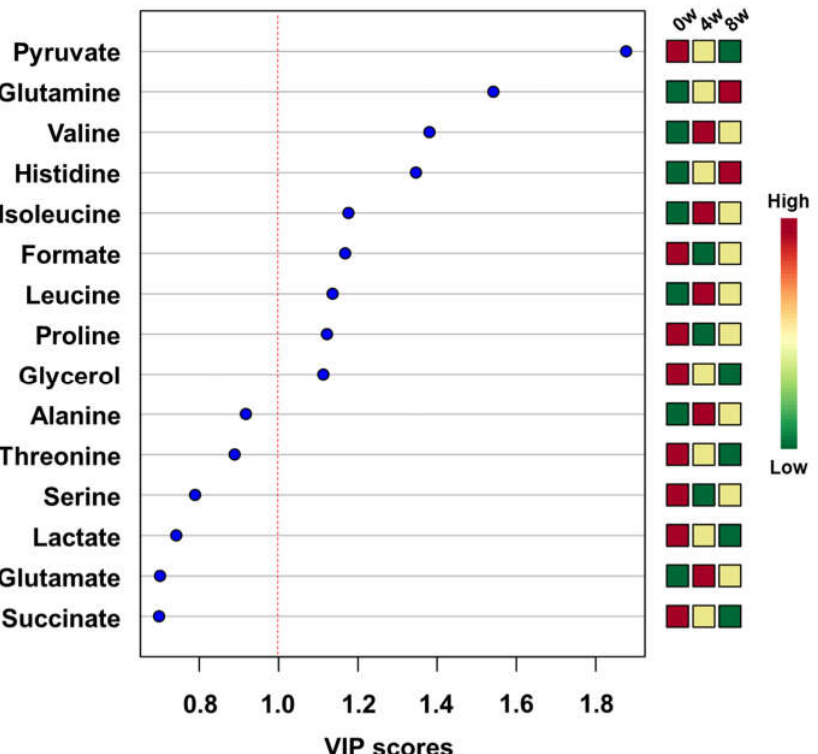
Figure 3. Top 15 metabolites in descending order according to variable importance in projection (VIP) values in the partial least squares discriminant analysis (PLS-DA). Table 2. Area under the curve (AUC) values of metabolites over 0.7 obtained from biomarker analysis of groups of before and after feeding of black ginseng.